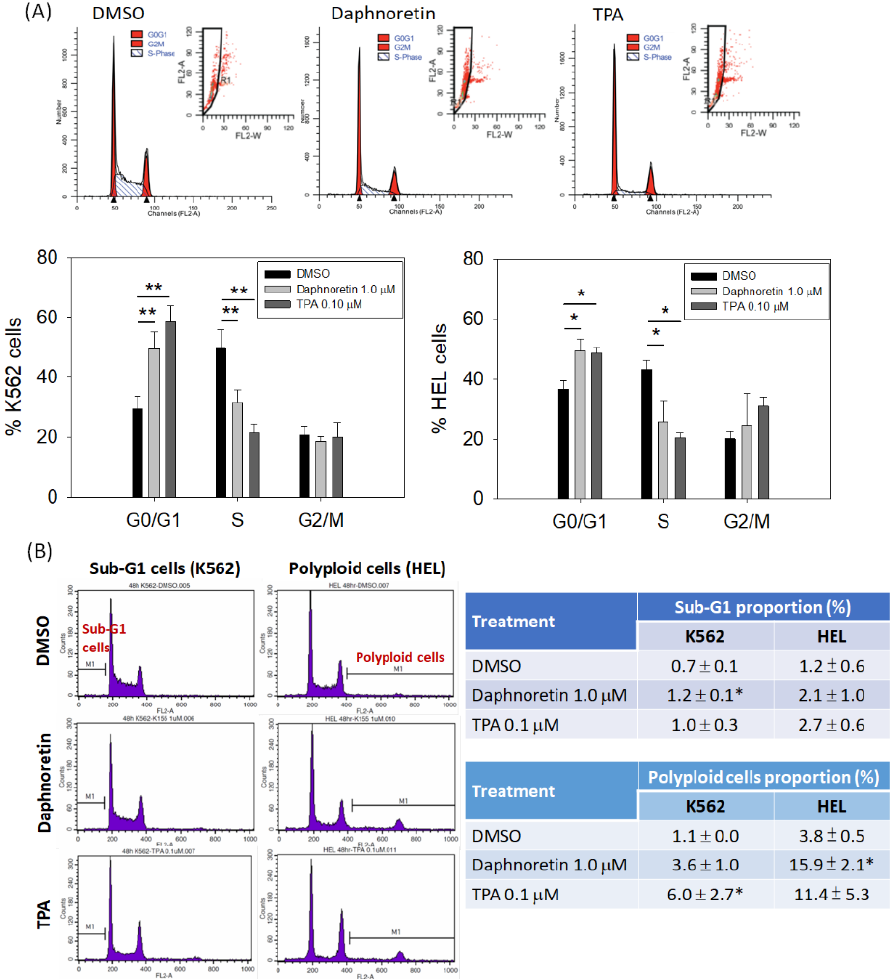
Figure 2. Effects of daphnoretin on the cell cycle distribution. Cells were treated with DMSO, daphnoretin (1.0 µ M), or 12-O-tetradecanoyl-phorbol-13-acetate (TPA; 0.1 µ M), followed by flow cytometric analysis. ( A ) Representative gating strategy of flow cytometry analysis in cell cycle distribution; ( B ) proportion of sub-G1 and polyploid cells at 48 h; * p < 0.05, ** p < 0.01 vs. DMSO- treated sample (ANOVA test followed by Dunnett’s post-hoc